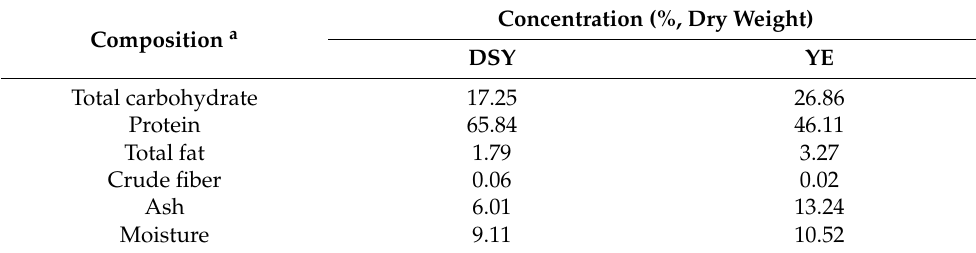
Table 2. The compositions of the dried spent yeast (DSY) and yeast extract (YE). Composition